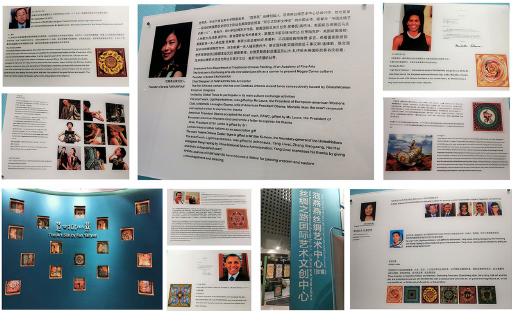
Figure 11. The center of silk arts and a bridge for global cultural communication